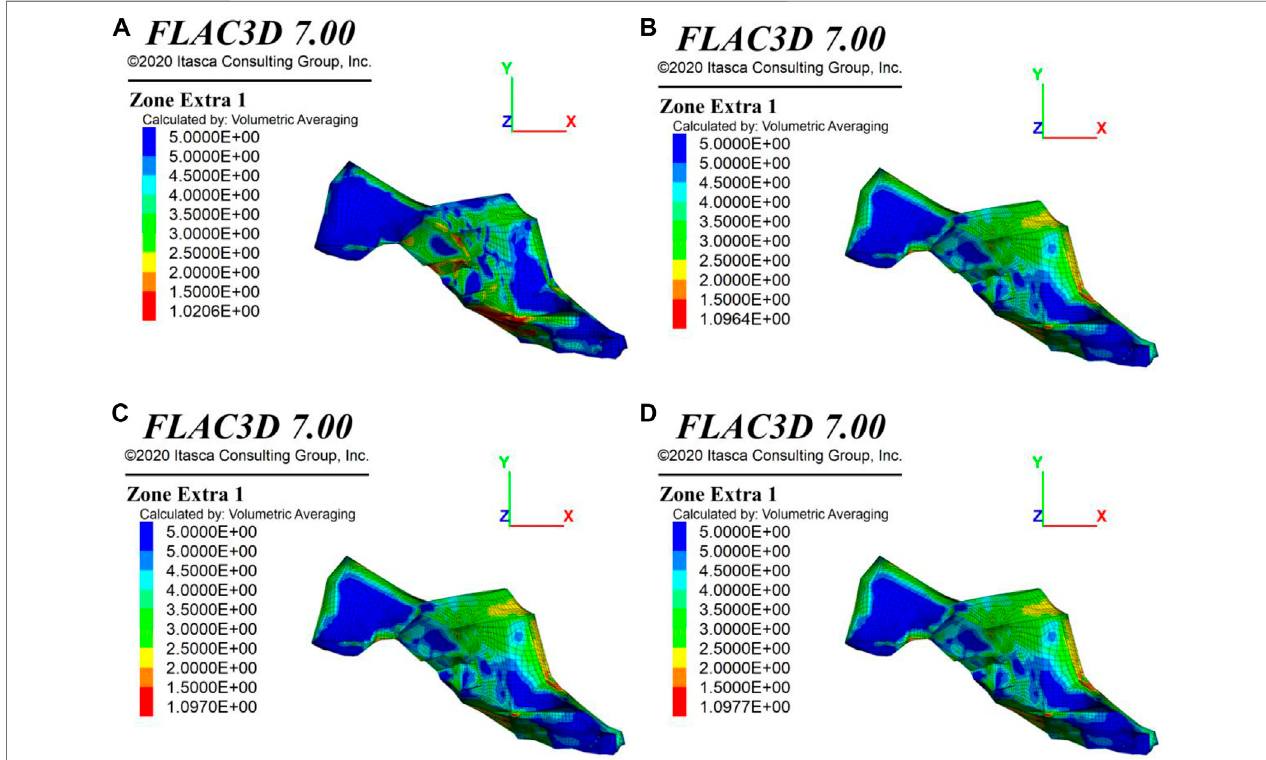
FIGURE11| Pointsafety factor ofsericitized slate forthe workingcondition of (A) Frequent fl ood, (B) Energydissipation design fl ood, (C) Check fl ood, (D) Normal operation + earthquake.